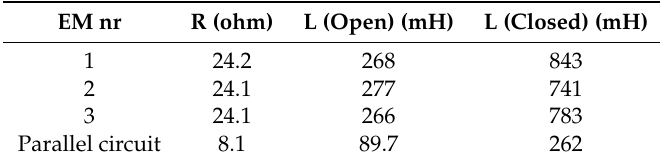
Table 3. Individual electromagnet values, measured at 100 Hz using an